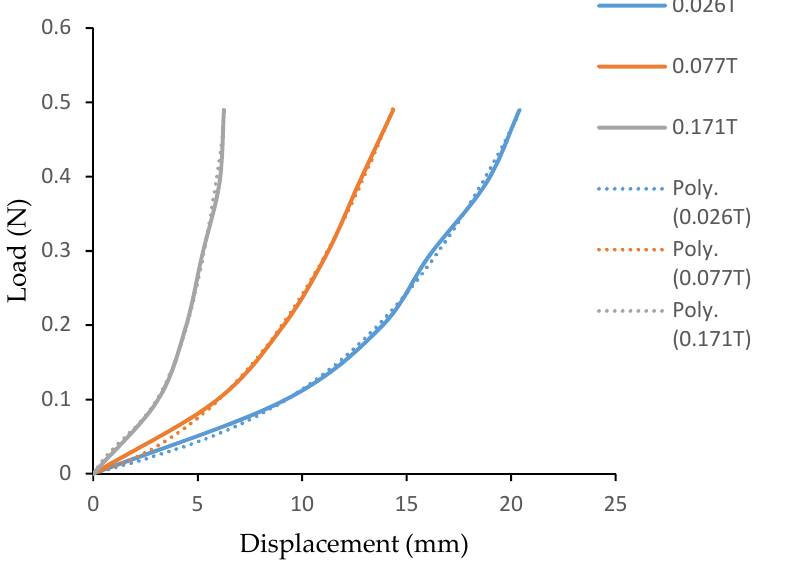
Figure 8. Load–displacement curve of cantilever structure with MR fluid for different magnetic field intensity. Table 3. Load–displacement relationship approximated by polynomial function in the cantilever structure with MR fluid. Magnetic Flux Density